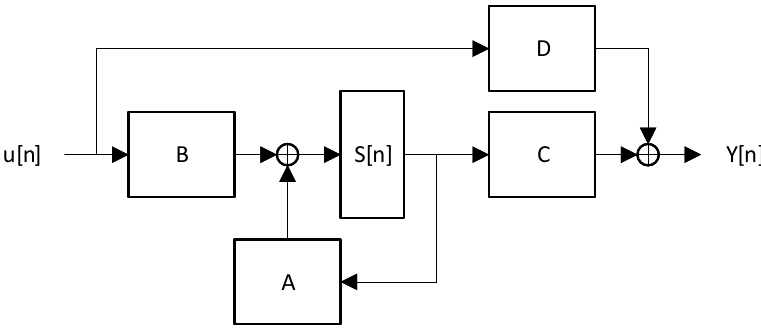
Figure 2. Block diagram of the ABCD matrices model of an RSC